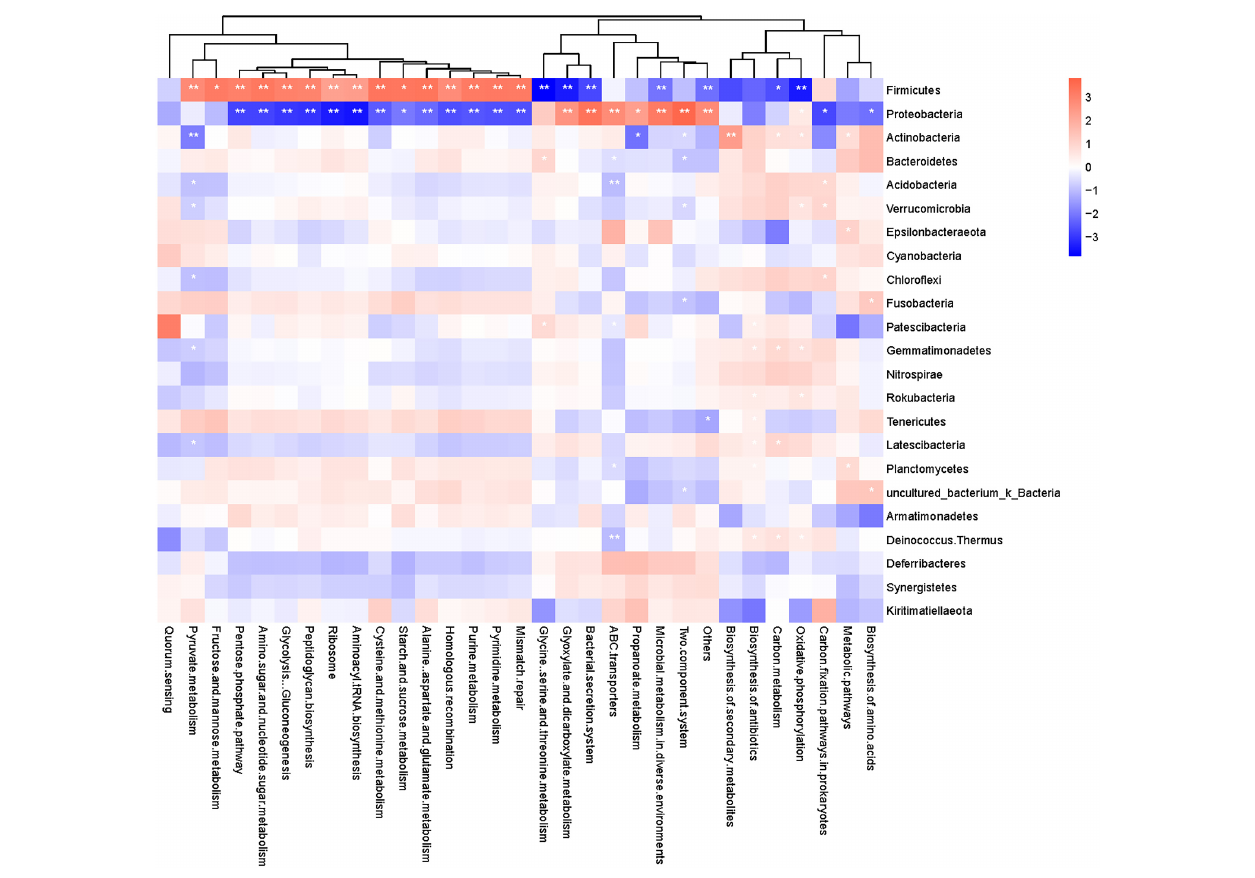
FIGURE 6 | Heatmap of correlation between metabolic pathways and gut microbiota of the common kestrels at the phylum level. The horizontal axis shows metabolic pathways, and the vertical axis shows different phyla. Red and blue indicate positive and negative correlations, respectively, and the deeper the color, the stronger the correlation. *and ** indicate significant differences at P < 0.05 and P < 0.01,